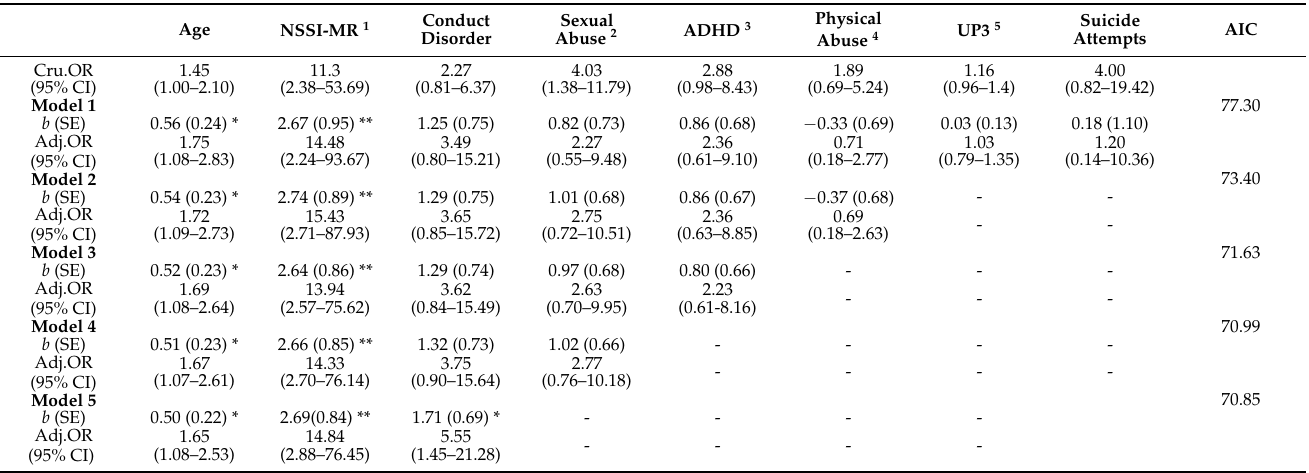
Table 3. Multiple logistic regression analysis of potential factors influencing personality disorders and self-injury behaviors in